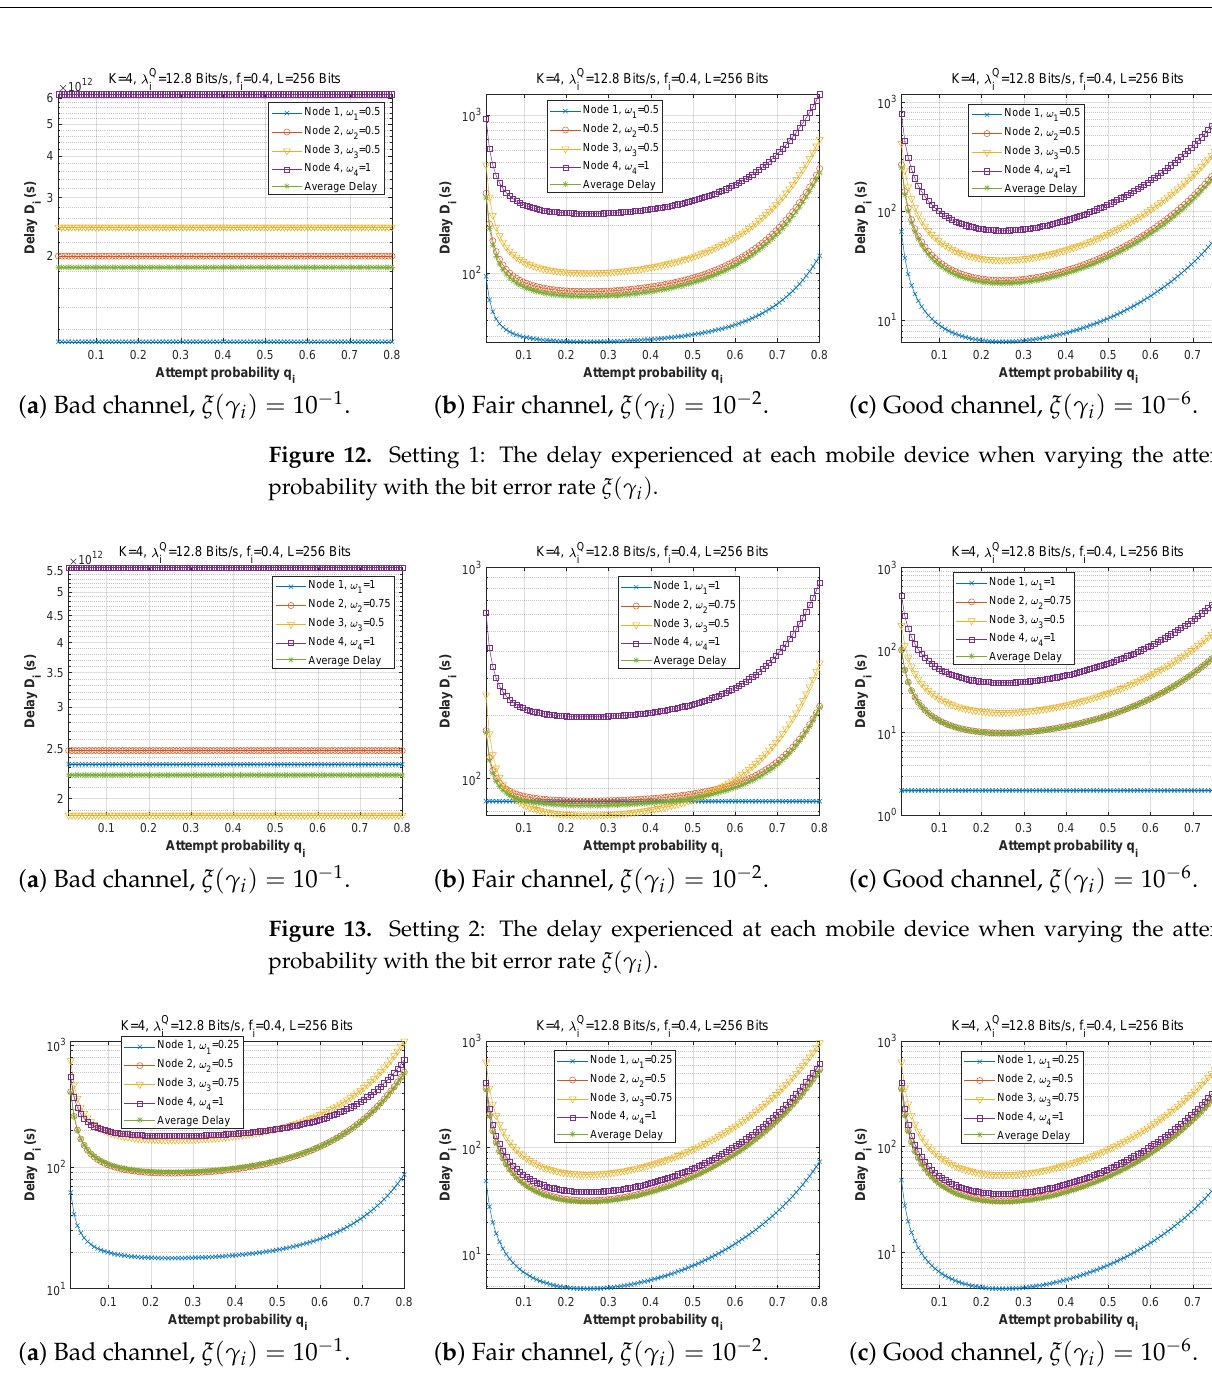
Figure 14. Setting 3: The delay experienced at each mobile device when varying the attempt probability with the bit error rate ξ ( γ i ) . Figure 15 demonstrates the delay encountered by each mobile device as a function of the = 1280 bits/s, attempt probability when the arrival rate in the queue is varied (heavy traffic, λ Q i = 128 bits/s, low traffic, λ Q = 12.8 bits/s) for the first, second, and third moderate traffic, λ Q i i scenarios. We conclude that the fluctuation of q i is unaffected by traffic density since the transmission delay is the same for all traffic categories in all three